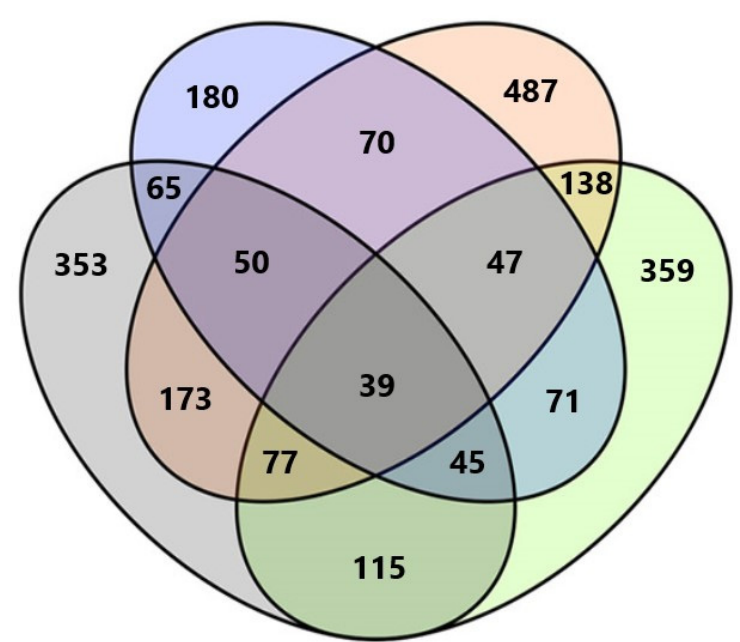
Figure 2. Venn diagram showing the diversity and overlap of fungal taxa in water filtrate samples from four forest nurseries. Different colors represent different forest nurseries: Green—Anykš č iai, Orange—Kretinga, Blue—Trakai, Gray—Dubrava.